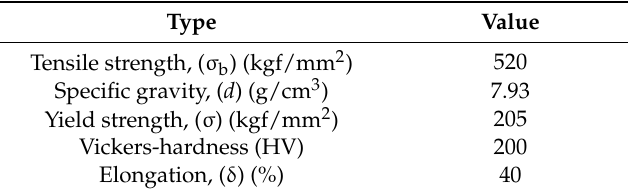
Table 1. Mechanical properties of AISI 304 austenitic stainless